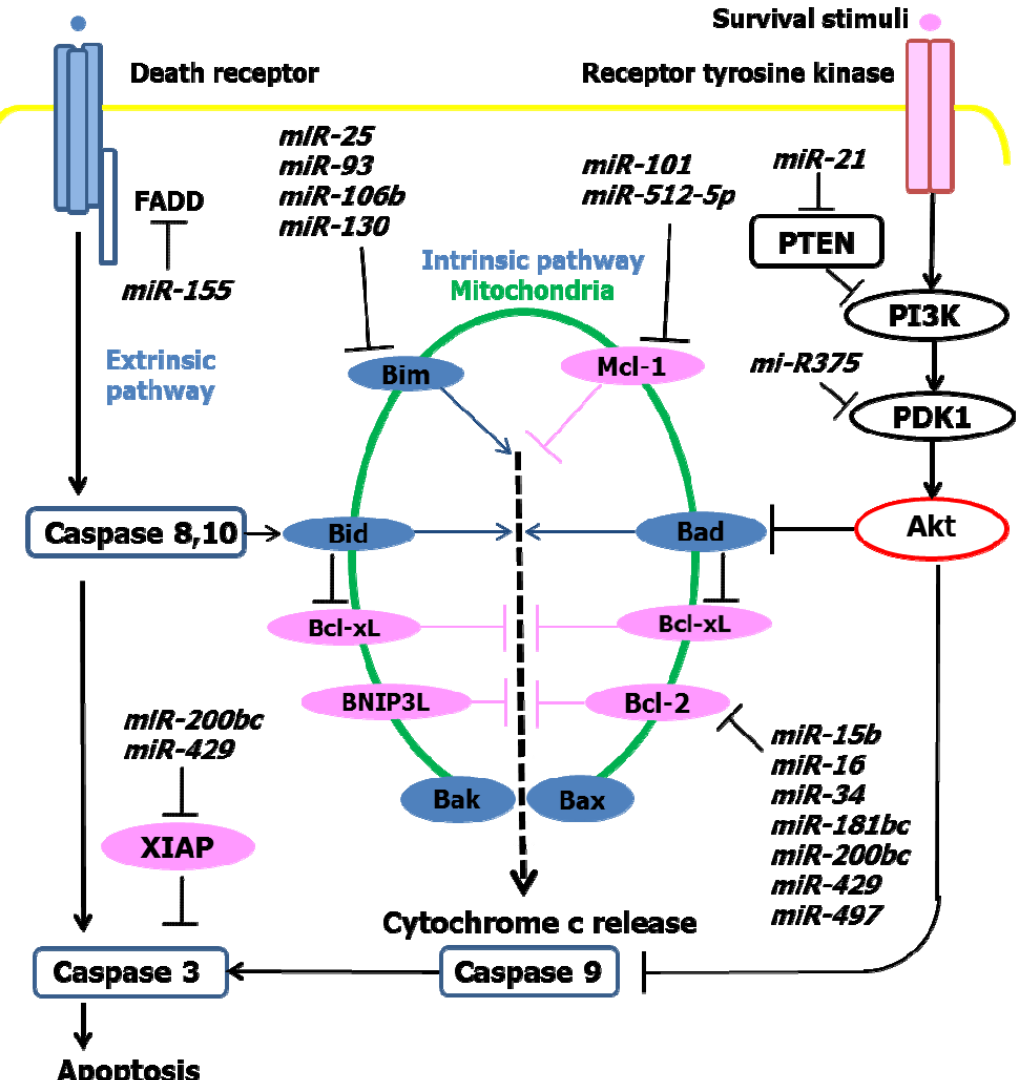
Figure 2. Signaling cascades that regulate the intrinsic and extrinsic pathways of apoptosis. Receptor tyrosine kinase detects survival stimuli such as growth factors and induces phosphoinositide 3-kinase (PI3K)/Akt signaling cascades that ultimately result in the inhibition of the pro-apoptotic protein, Bad. Pro-apoptotic and anti-apoptotic proteins govern the intrinsic cell death pathway, which results in the release of cytochrome c from the mitochondria and induction of the caspase cascade. Signaling through death receptors initiates the extrinsic pathway of